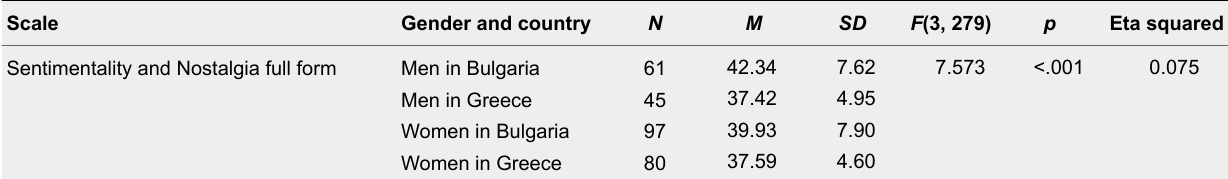
Gender Differences in Sentimentality and Nostalgia Between the Elderly People in Bulgaria and Greece